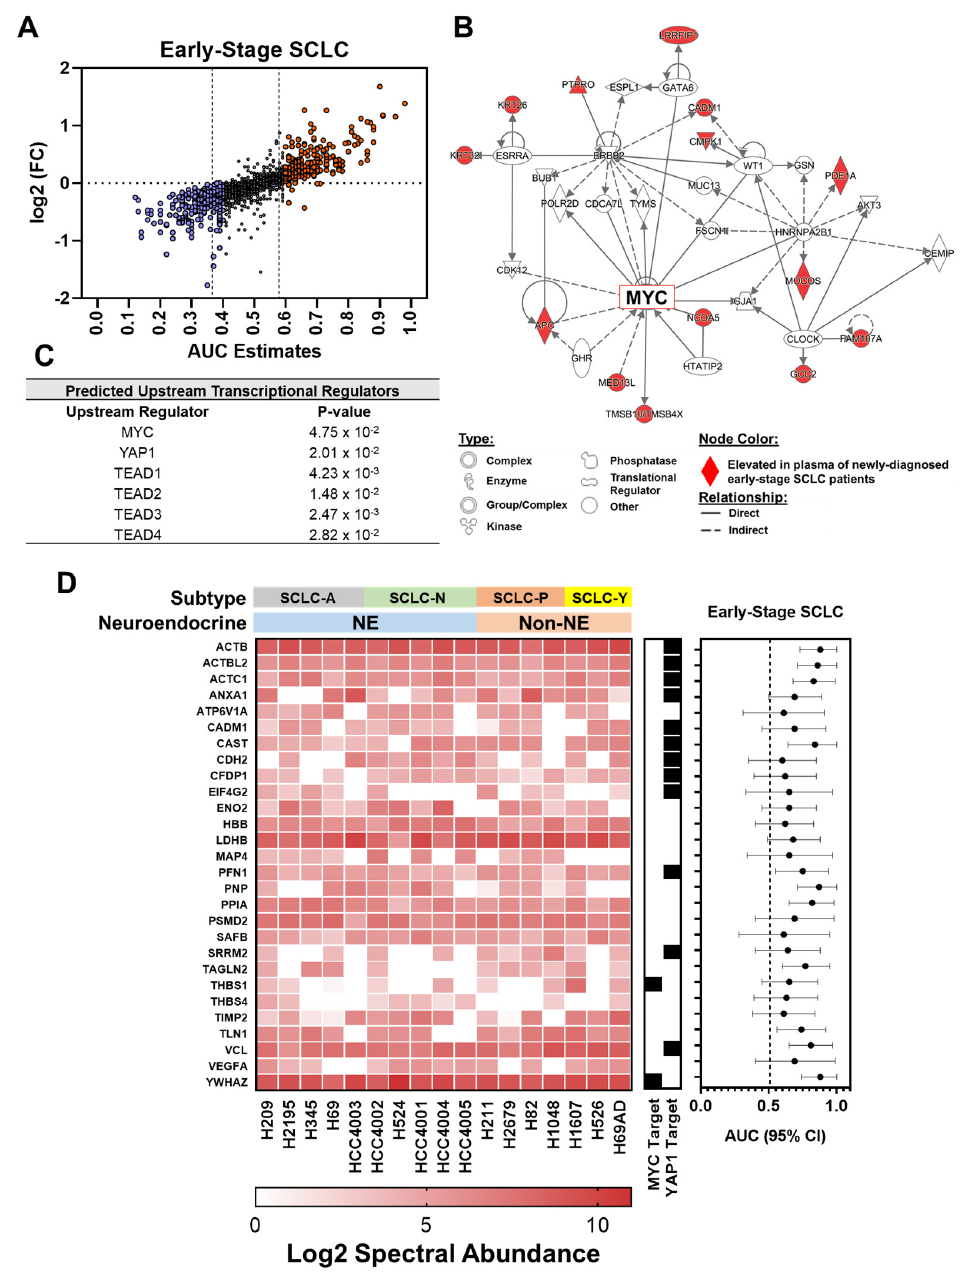
Figure 1. Proteomic profiling of newly diagnosed early stage SCLC patient plasmas reveals signatures associated with oncogenic drivers. ( A ) Distribution plot comparing illustrating the AUC ( x -axis) and fold-change ( y -axis) of circulating proteins for distinguishing early stage SCLC cases from matched controls. ( B , C ) Ingenuity Pathway Analyses (IPA) on circulating proteins that exhibited an AUC ≥ 0.60 for distinguishing early stage SCLC cases from matched controls reveals MYC ( B ) and YAP1-centric signatures ( C ). ( D ) Heatmap illustrating the 28 proteins that were quantified in conditioned medium of SCLC cell lines ( n = 17) and that were elevated in plasmas of early stage SCLC cases. The center plot annotates whether the respective protein is a reported downstream transcriptional target (black square) of MYC or YAP1. ChIP Enrichment Analysis (ChEA) transcriptional targets of c-MYC and YAP1 were downloaded from Harmonizome database [29,30] . The scatter plot on the right depicts the AUC (95% CI) of respective proteins for distinguishing early stage SCLC cases from matched controls in the MDACC cohort.